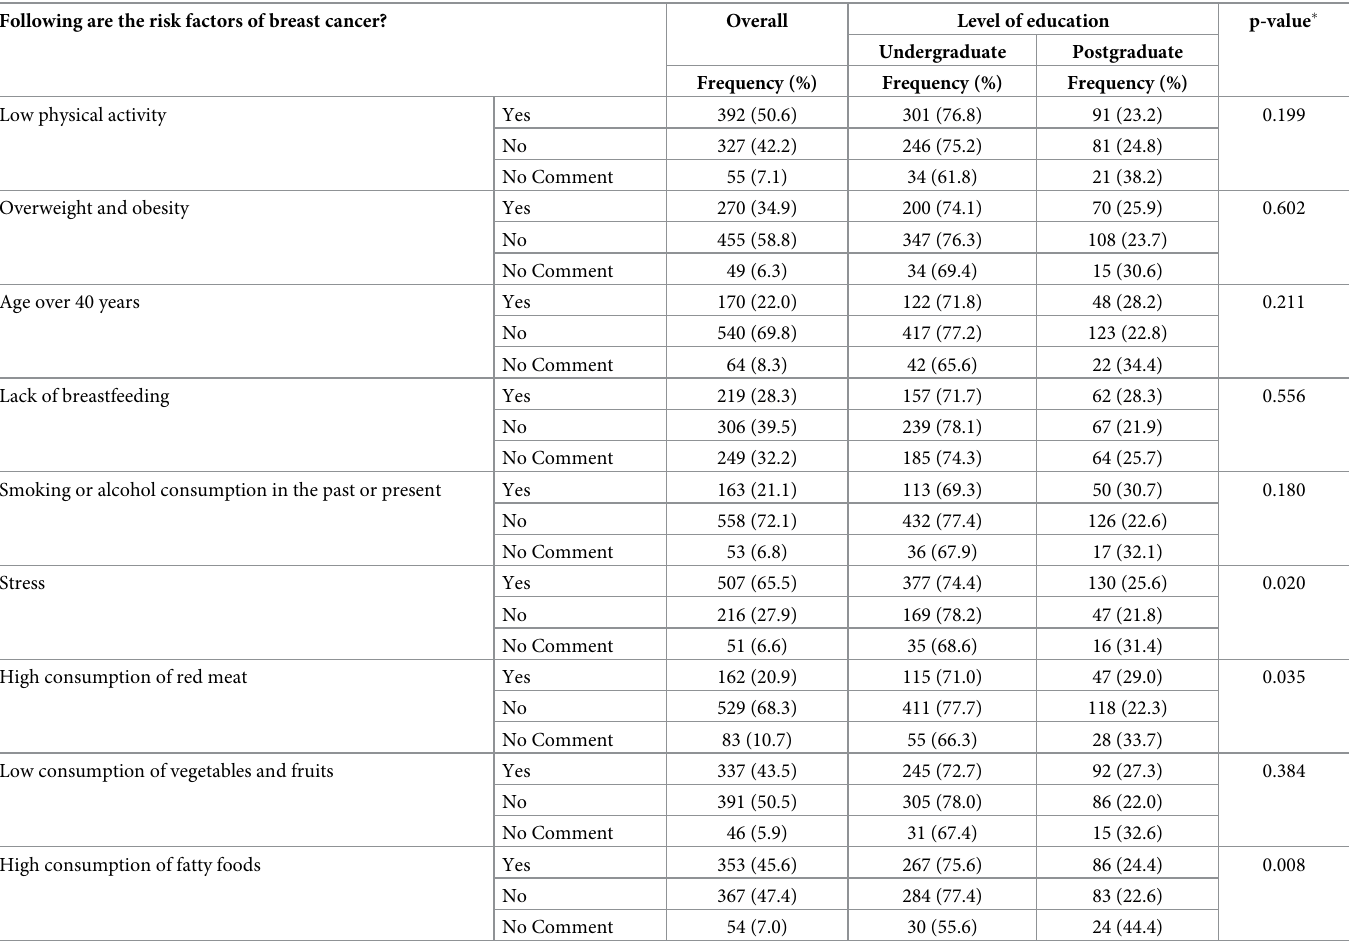
Table 4. Participant’s knowledge of breast cancer’s risk factors related to physical activities, and lifestyle. Following are the risk factors of breast